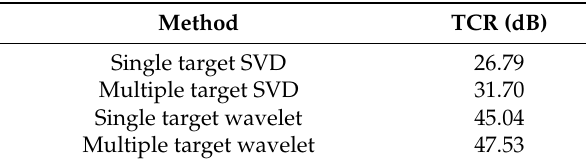
Table 4. Comparison of wavelet and SVD